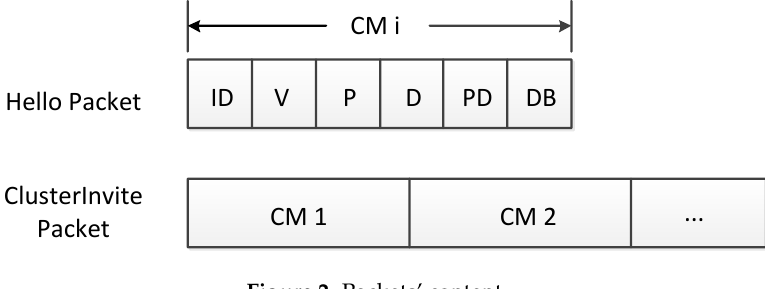
Figure 2. Packets’ content.